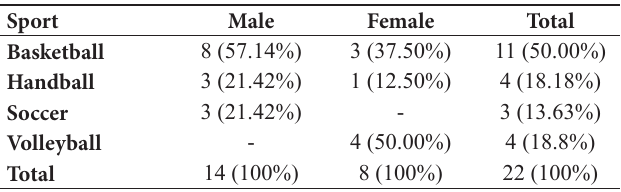
Table 1. Sports modality practiced by the adolescents with pa- tellofemoral pain of athletes group.